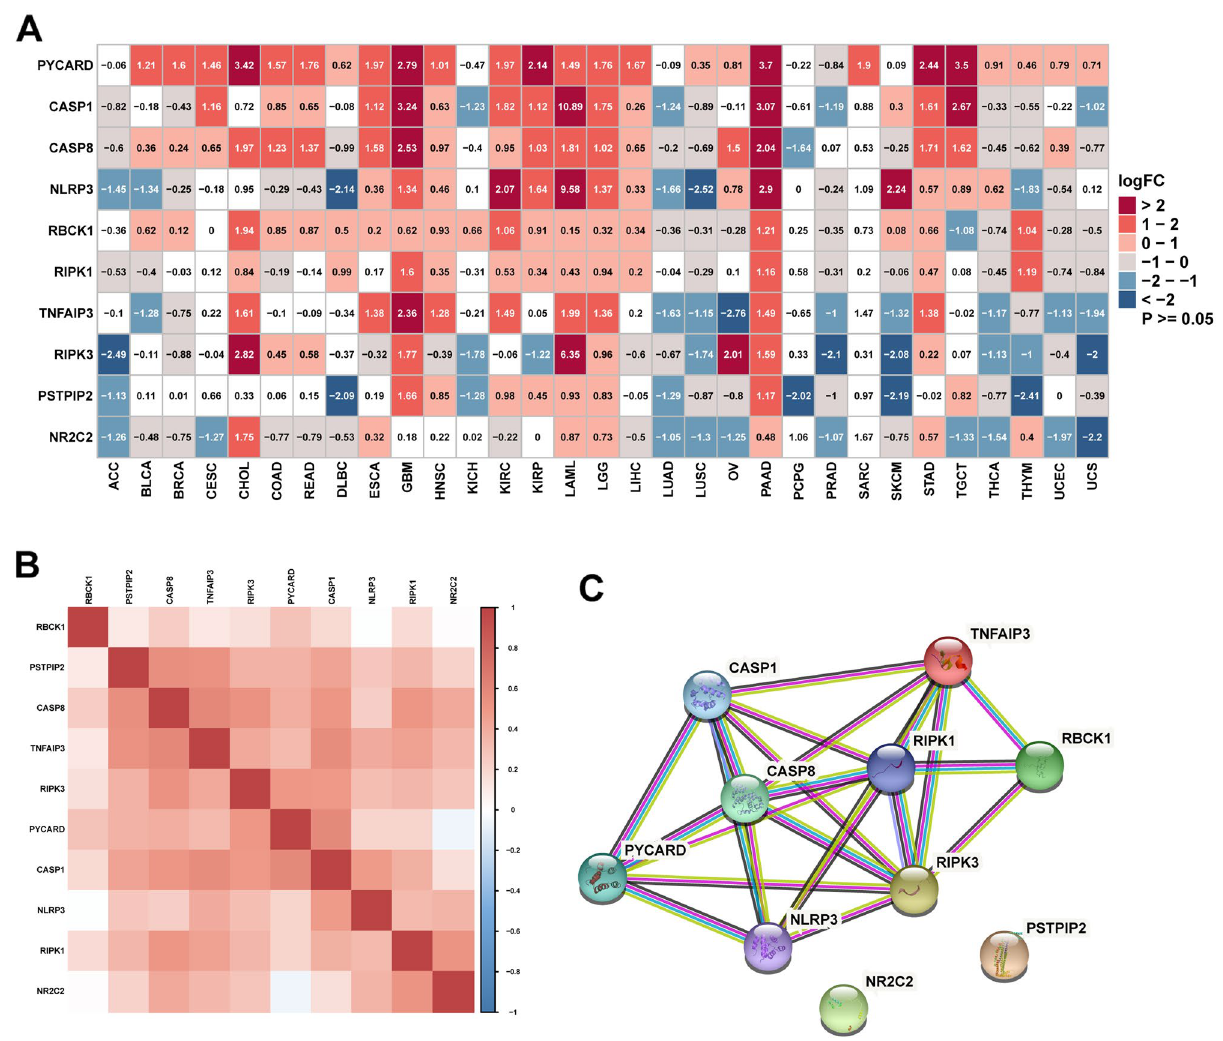
Figure 1. The expression of PANoptosome components. ( A ) The differential expression of PANoptosome components between tumor and normal tissues in pan-cancer based on TCGA and GTEx databases. Red represents high expression, and blue represents low expression in tumor. P value and logFC are presented. ( B ) The correlation analysis of PANoptosome members in TCGA database. Darker shades mean a stronger correlation. ( C ) Protein–protein interaction (PPI) network of